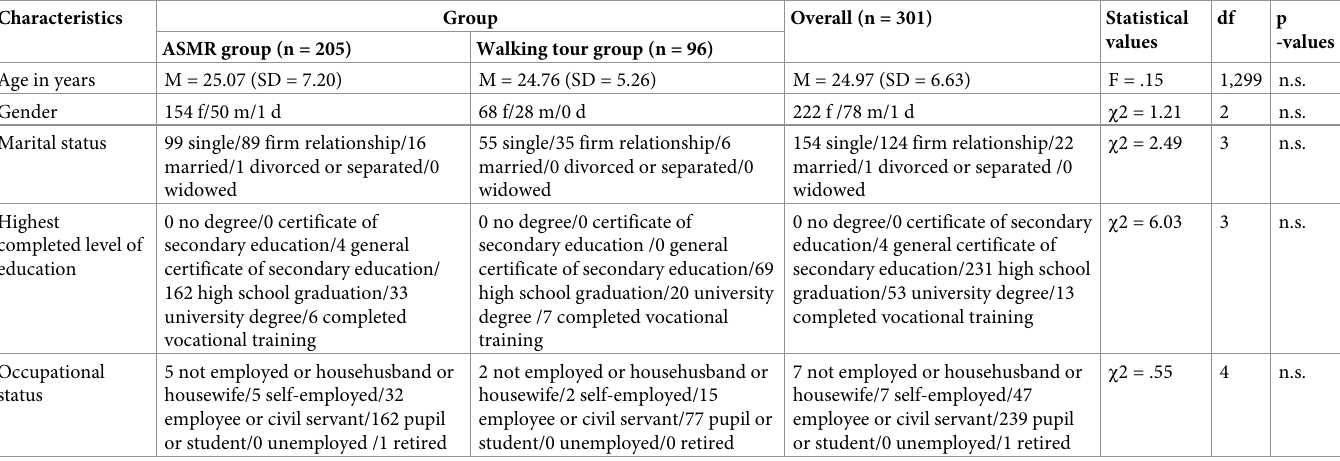
Table 1. Demographic characteristics of the different study groups (ASMR vs. walking tour).